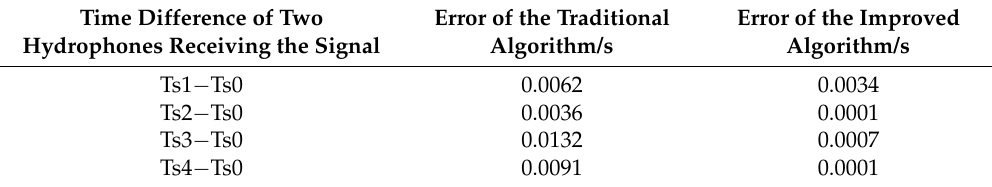
Table 2. Error comparison of the calculation values of the time difference.